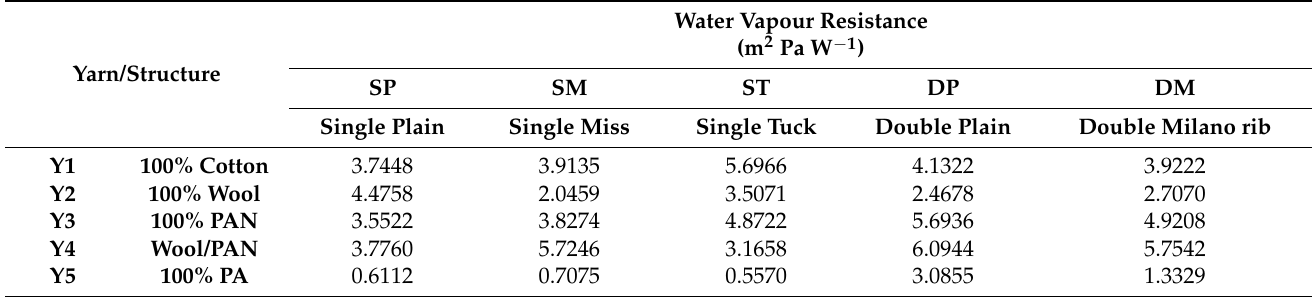
Table 7. Water vapour resistance of knitted